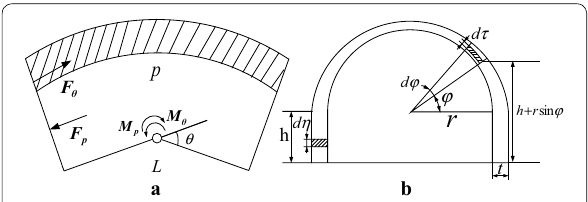
Figure 6 a Static model of the finger joint during bending; b Cross-sectional view of the finger axle of the joint, while the silicon rubber extends when pressurized. When p is pressurized, the base of the finger joint only bends around the axis of rotation without extension the silicon rubber F θ and the acting force F p between the because of the limitation of the endoskeleton. The bend- endoskeleton units. Accordingly, there is a balance among ing angle θ and radius of curvature correspond to each (cid:31) the torques around the axis of rotation. The torque generated finger joint. The radial stretch ratio 2 is assumed to be 1 by the internal air pressure acts as the driving moment M p , because of the fiber restrained layer. The axial stretch ratio (cid:31) (cid:31) the torque generated by the stretching stress is the resistance . The silicon rubber layer stretches 1 is determined as (cid:31) moment M θ , and the torque of the acting force is 0. uniformly. The circumferential stretch ratio 3 can be The torque equilibrium can then be obtained as determined from the ratio of the stretched and initial thick- nesses. Then according to Eq. (4), the following is obtained. The driving moment M p generated by the internal air pressure can be written as